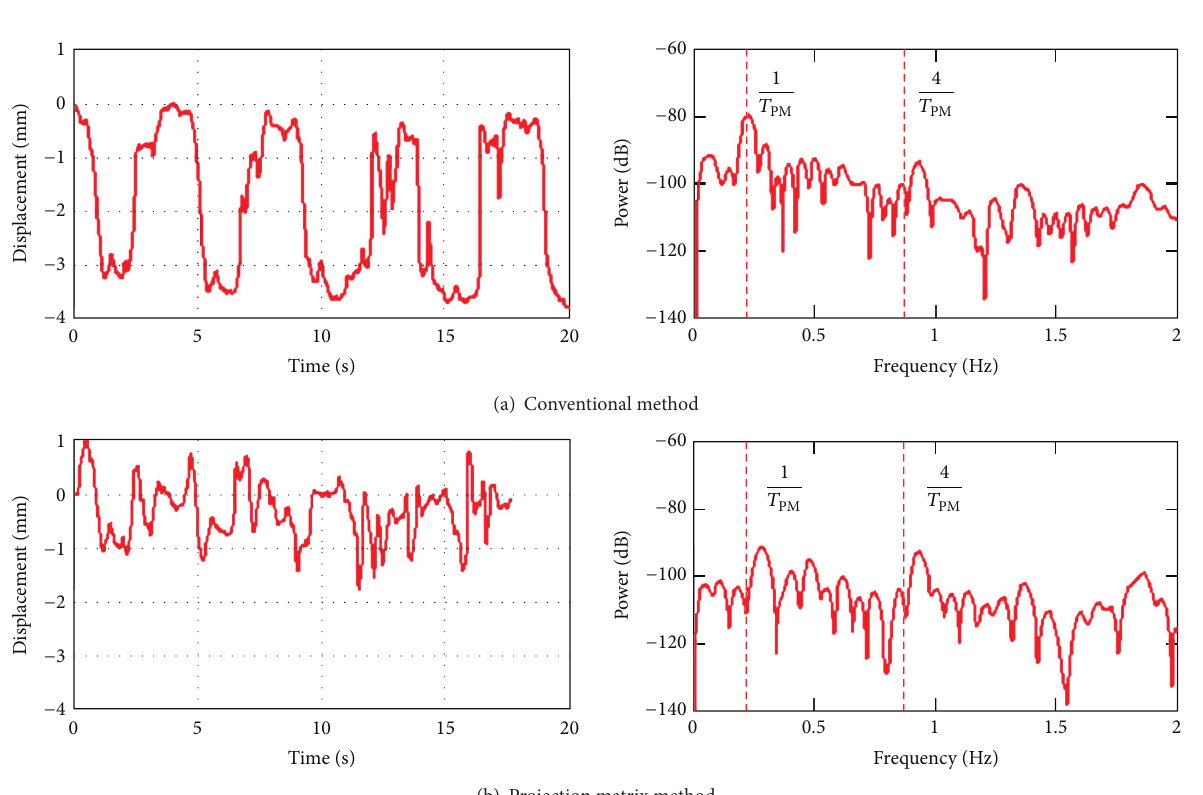
Figure 5: Signal processing results at the distance of 40